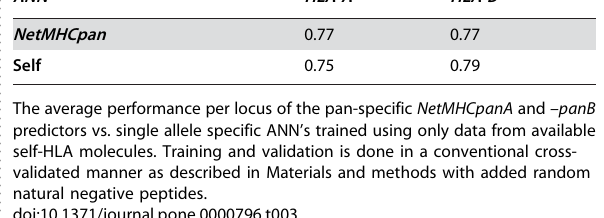
Table 3. Performance of the pan-specific binding predictors. . ... ... .... ... ... .... ... ... .... ... ... .... ... ... .... ... ... .... ... ... ...